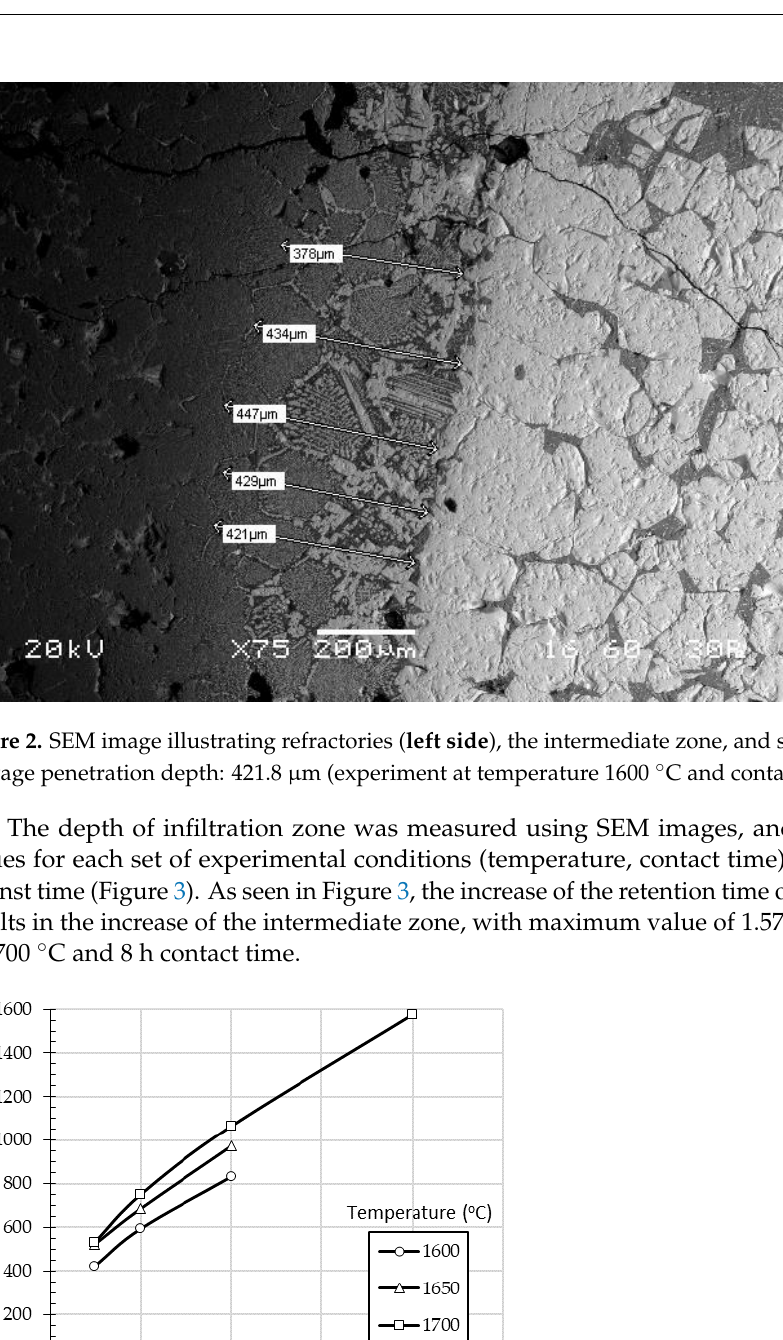
Figure 3. Depth of infiltration zone (μm) vs. contact time and temperature.